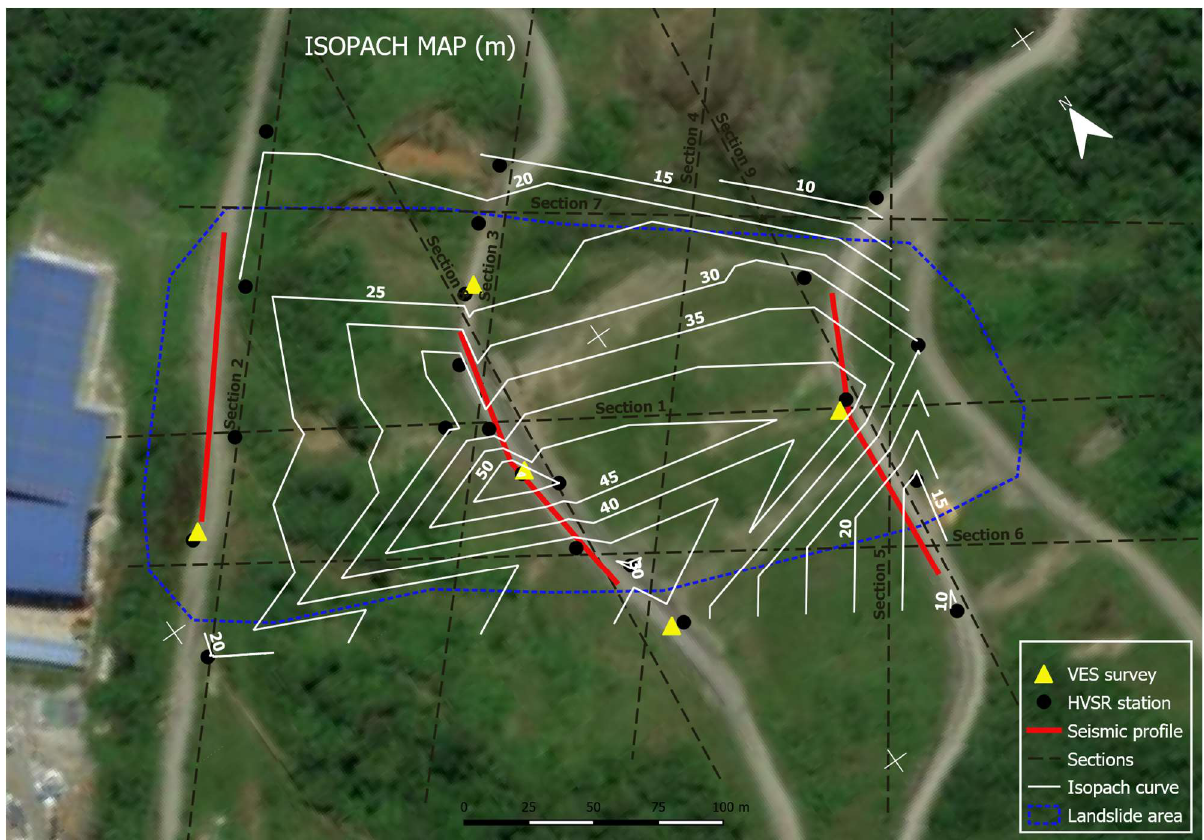
Figure 9. Isopach map (sediment thickness) traced with contour lines every 5 m thick (white lines) are represented with geological section positions (dashed black lines). White crosses refer to the coordinate points (Modified from [22]).